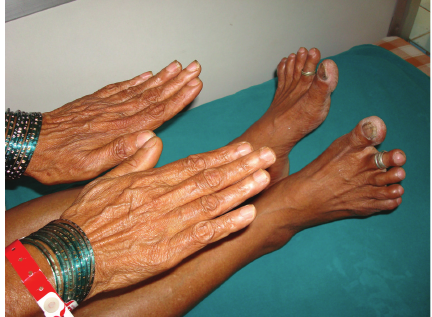
Figure 1: Clubbing of digits of feet with no edema or skin changes at ankles.